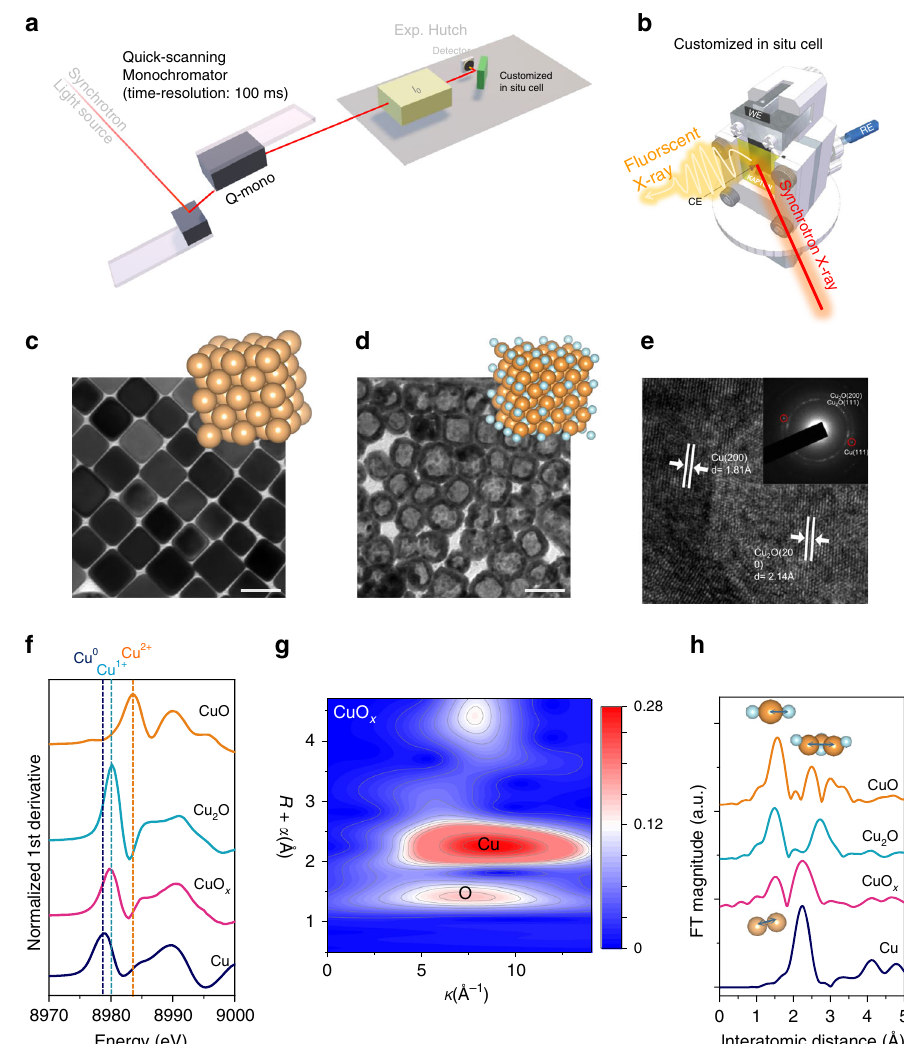
Fig. 1 Experimental setup and catalyst characterization. a The schematic diagram of the setup of operando time-resolved XAS experiments. b The cartoon representation of customized operando XAS cell. c TEM image of Cu nanocubes. d TEM image of CuO x . Scale bars are 50 nm. e HR-TEM image and SAED pattern (inset) of CuO x . f First derivatives of the Cu K-edge XANES spectra of CuO x and of commercial Cu, Cu 2 O, and CuO as references. g , h Wavelet transform-EXAFS of as-prepared CuO x and the Fig. 1f, the normalized 1st derivative of X-ray absorption near edge structure (XANES) of CuO x and references suggested that no detectable Cu(II) species existed in the as-prepared CuO x 39 . On the other hand, a strong peak overlapping that of Cu 2 O at ~8980 eV indicated the presence of Cu(I) species in the CuO x catalyst. Notably, a slight difference between the normalized absorbance at 8981 eV of CuO x and that of Cu 2 O might be